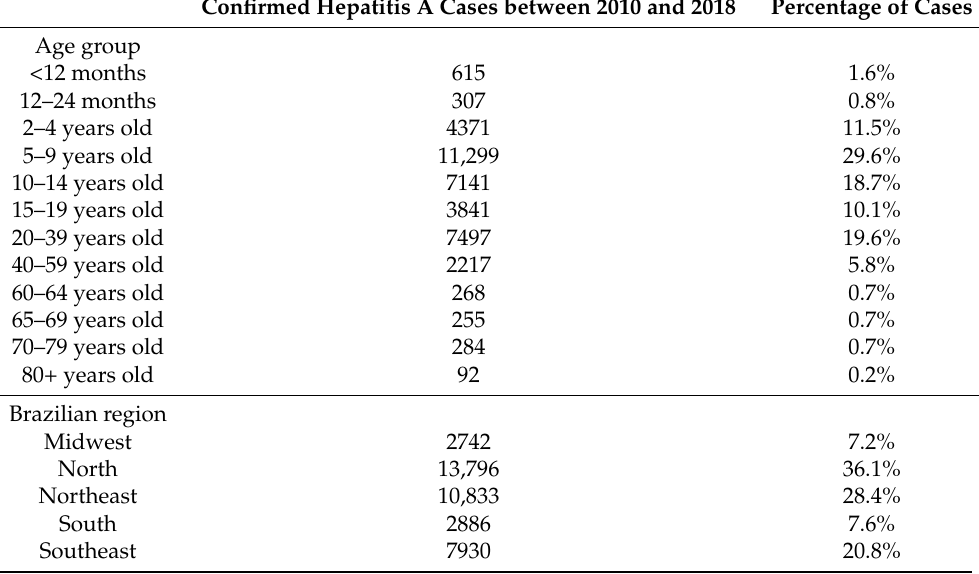
Table A1. Hepatitis A cases reported between 2010 and 2018 (including the year of 2014) according